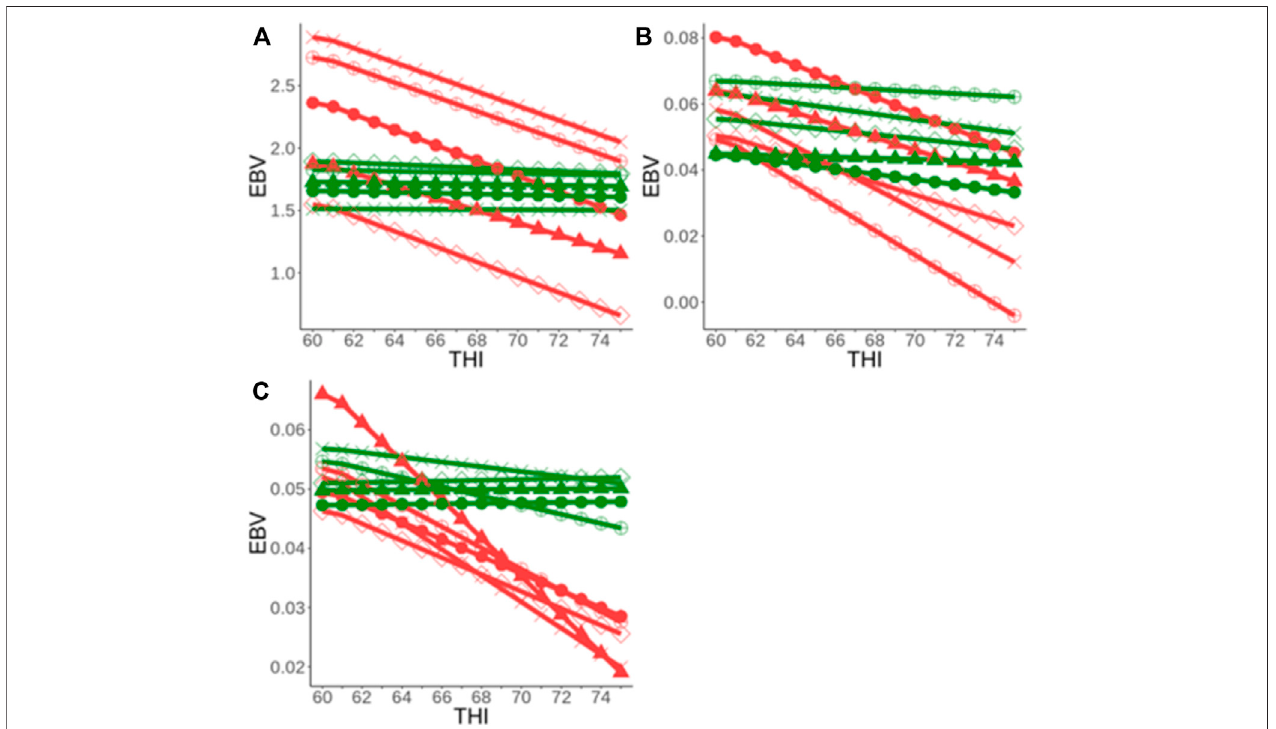
FIGURE 5 | Reaction norm of the EBVs along the trajectory of THI (heat stress) for a sample of bulls in Australia for heat tolerance milk (A) , fat (B) , and protein (C) yield slope traits [adapted from (Cheruiyot et al., 2020)].